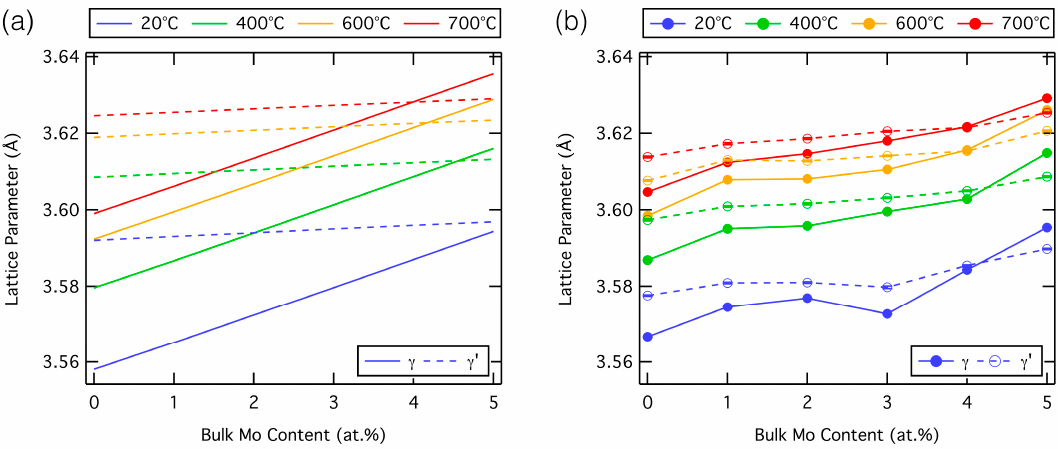
Figure 3. Lattice parameters of the γ and γ′ phases as a function of nominal bulk Mo content, ( a ) predicted by ThermoCalc and ( b ) experimentally measured by neutron diffraction.